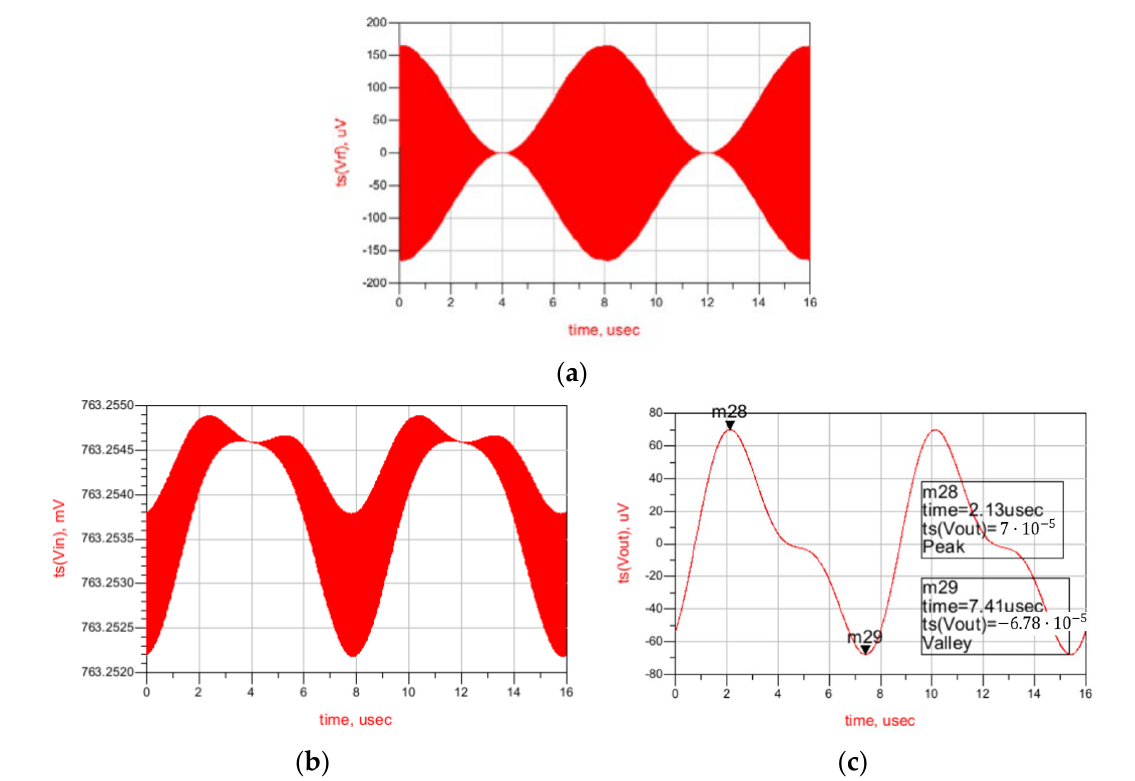
Figure 7. Time-domain simulation results of the WuR with amplification and low-pass filtering stages. AM input signal (V rf ) ( a ), the output of the first stage (V in ) ( b ), and the output of the second stage (V out ) ( c ). Table 1. Summary of component values for the tuned RFED with feedback amplifier WuR. Parameter Value